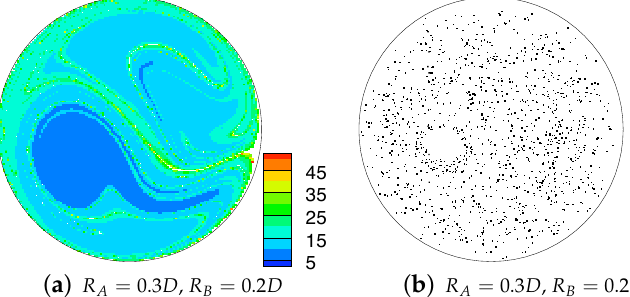
Figure 8. Initial particle distribution, coloured by total residence time of the particle over six pitch lengths ( left ) and Poincaré sections generated by 50 iterations of the combined mapping ( right ). Islands of ’no mixing’ can be seen to correspond in both Poincaré sections and residence